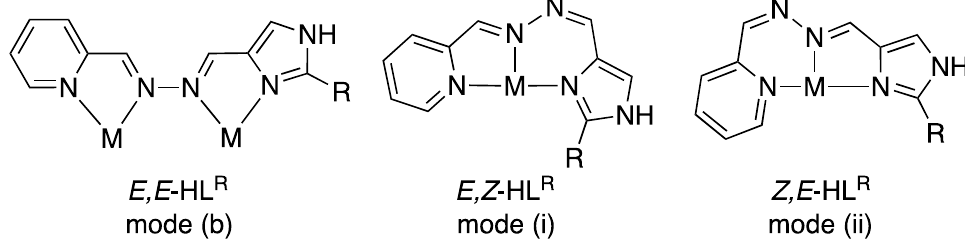
Table 1. Crystallographic data of compounds 1 ·MeOH and 2 ·H 2 O·Et 2 O.